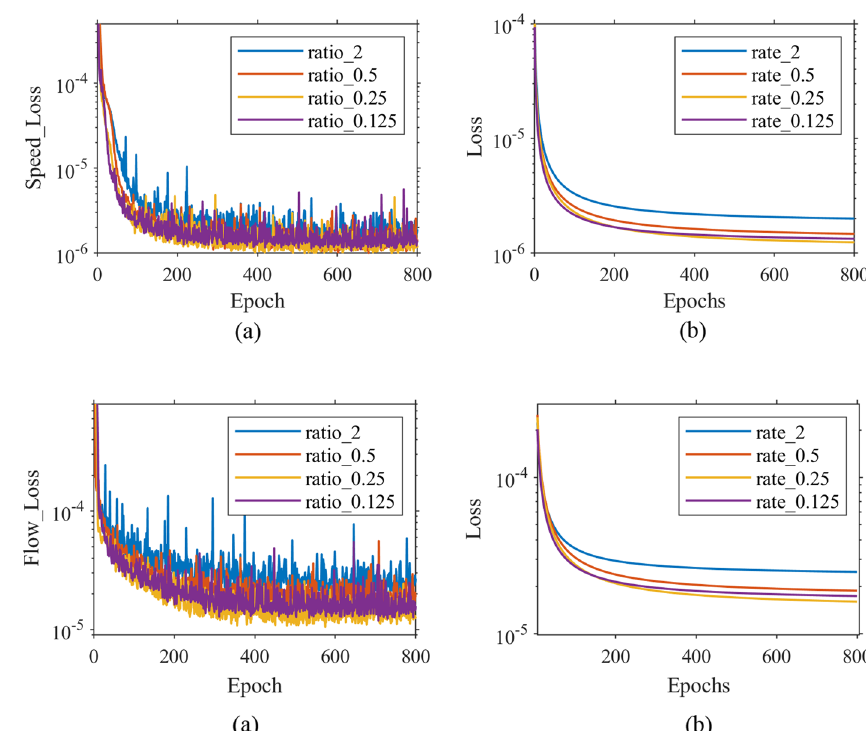
Table 3 The extraction results of different ratios